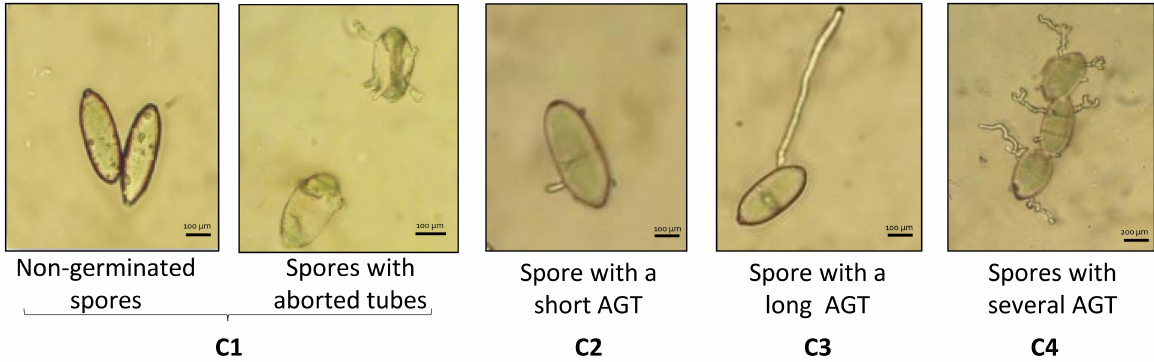
Figure 6. Four categories of events observed in vitro for B. graminis f.sp. tritici spores exposed to tested molecules diluted in agar medium: non-germinated spores + spores with aborted tubes C1, with a small appressorial germ tube (AGT) C2, spores with a long AGT C3, spores with several AGT